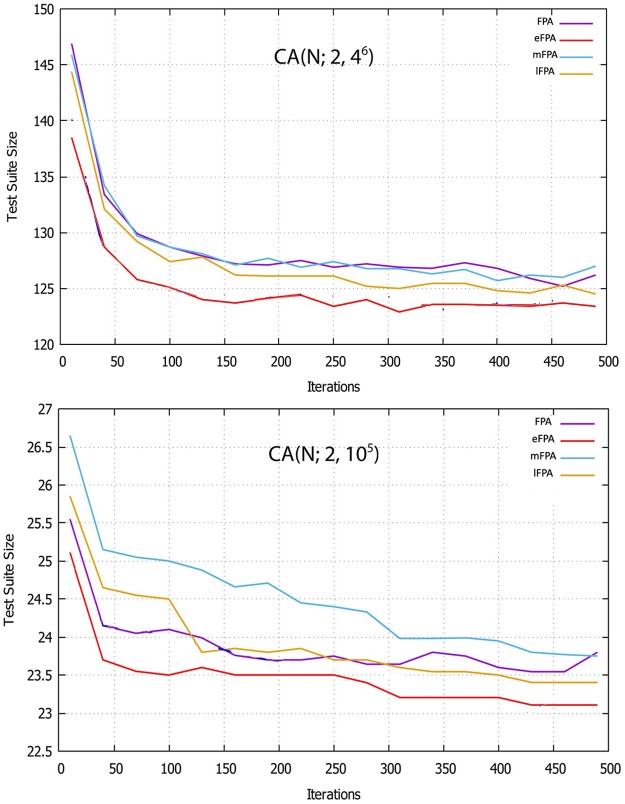
Convergence rate of hybrid variants of FPA for CA (N; 2, 105) and CA(N; 2, 46).